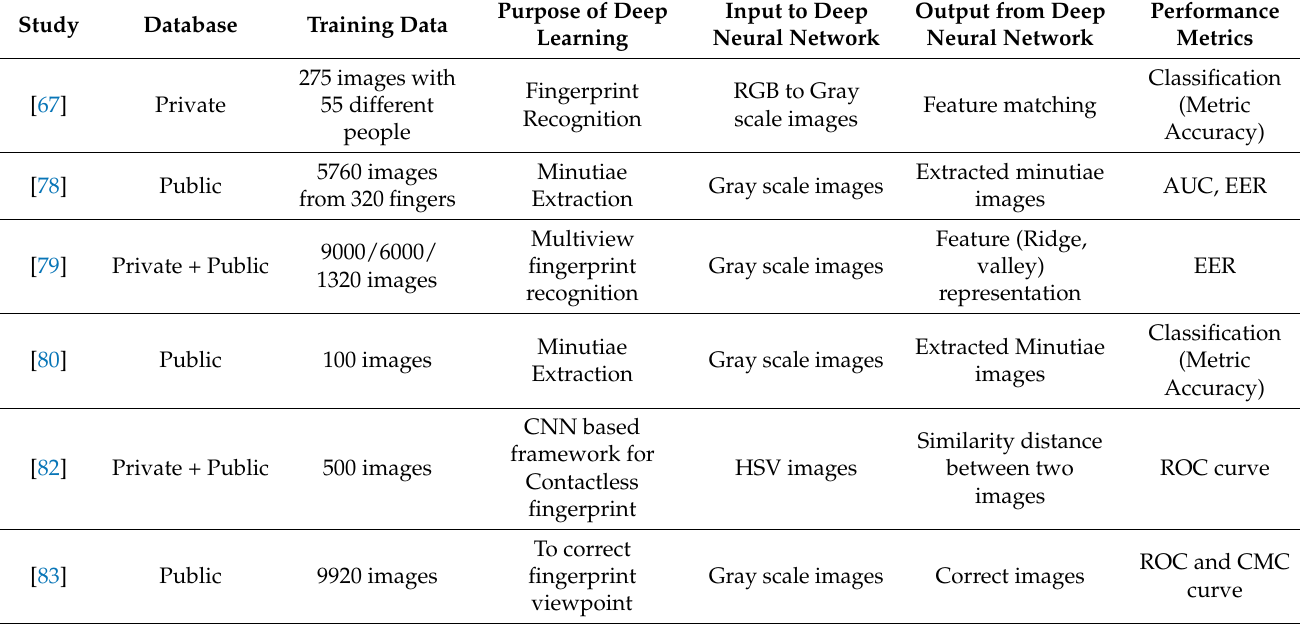
Table 5. The following table describes the summary of the